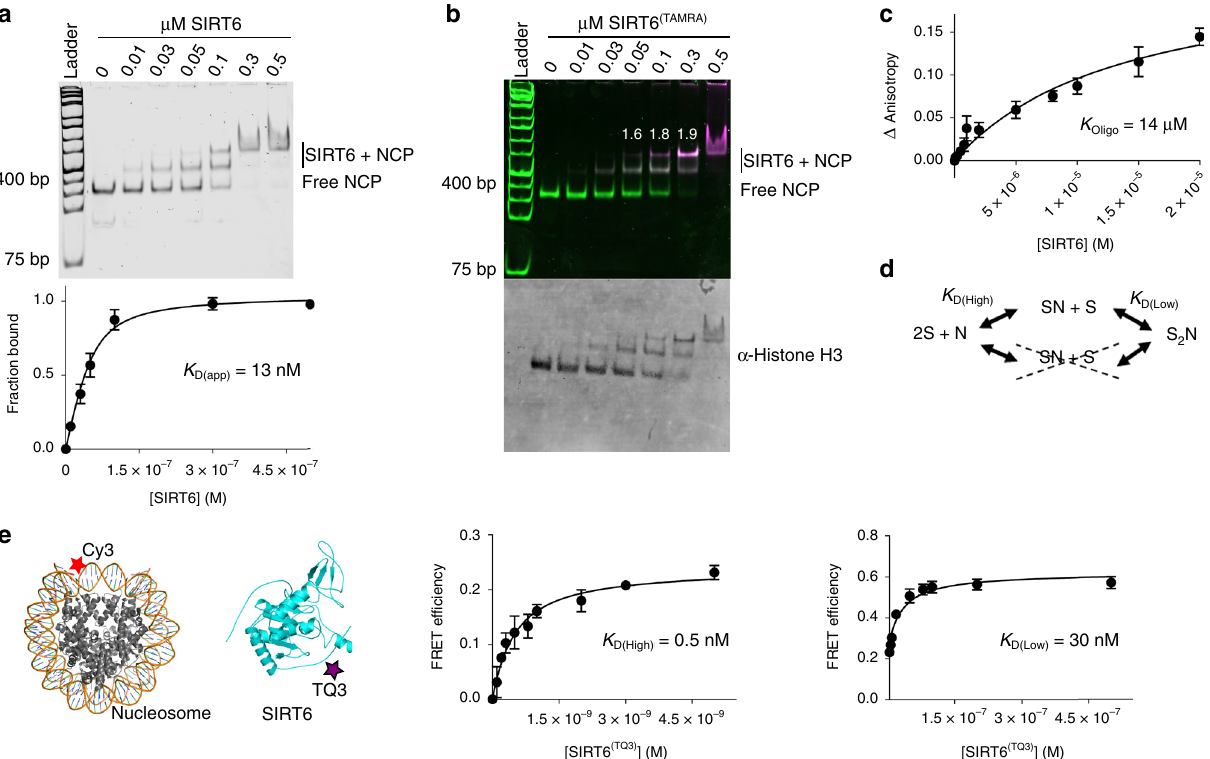
Fig. 1 SIRT6 and NCPs assemble with low nanomolar af fi nity via a two-site binding mechanism. a EMSA of NCPs bound to varying SIRT6 concentrations, then detected by SYBR Safe fl uorescence. Data are presented as the mean ± s.d. from six independent experiments. The apparent K D was calculated using a ligand-depleted equation. b SIRT6:NCP stoichiometry was determined by detecting fl uorescence from both SYBR Safe-stained DNA and TAMRA-labeled SIRT6. The white numbers indicate the relative TAMRA signal in the higher shifted band compared to the lower bound band, both normalized to DNA content. The gel was subsequently blotted for histone H3. The image is representative of three independent experiments. c To measure SIRT6 self-oligomerization, the fl uorescence anisotropy of pyrene-labeled SIRT6 was monitored with titration of unlabeled SIRT6. Data are presented as mean ± s.d. from three independent experiments. d The data indicates a two-site binding mechanism, in which two SIRT6 molecules bind at separate sites on a nucleosome. e A FRET assay was employed to measure binding between 1 nM of Cy3-labeled nucleosomes and SIRT6 labeled with TQ3, which accepts energy transfer from Cy3. The titration reveals a two-site binding curve (Supplementary Fig. 2f). The intermediate binding constant K D(High) was fi tted to a ligand-depleted equation from titration points up to 5 nM SIRT6 (TQ3) , while K fi tted to a speci fi c-binding equation from data points D(Low) was